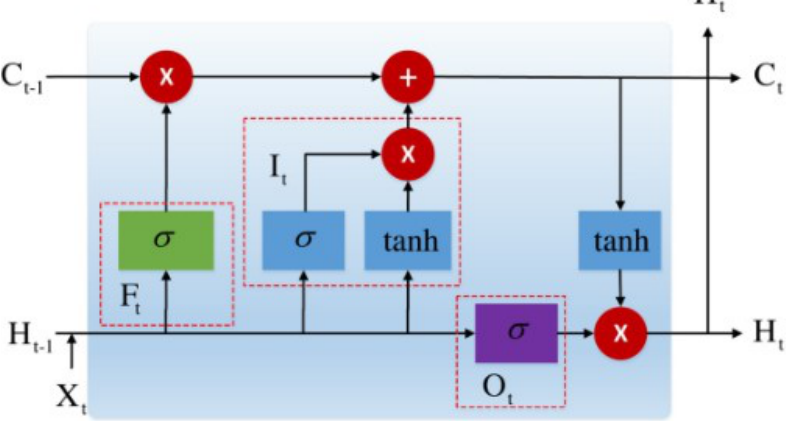
Figure 1. Schematic of LSTM with F t = forget, I t = input, O t = output gate, C t = cell memory state, and H t = hidden state